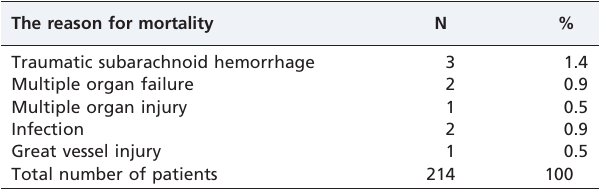
Table 4 - Reasons for